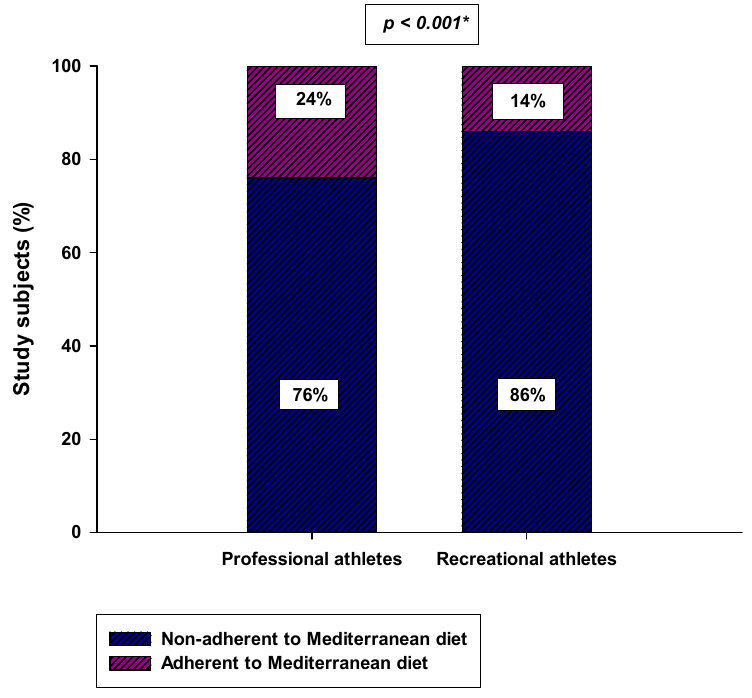
Figure 2. Difference in the number of participants adherent to the MD (MDSS score ≥ 14) between the professional athlete group ( N = 150) and the recreational group ( N = 150). * Chi-square test.